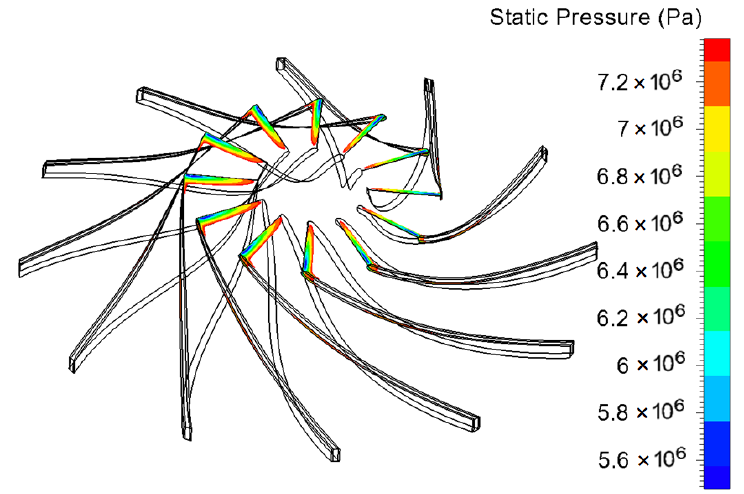
Figure 18. The cross critical region of the blade surface.